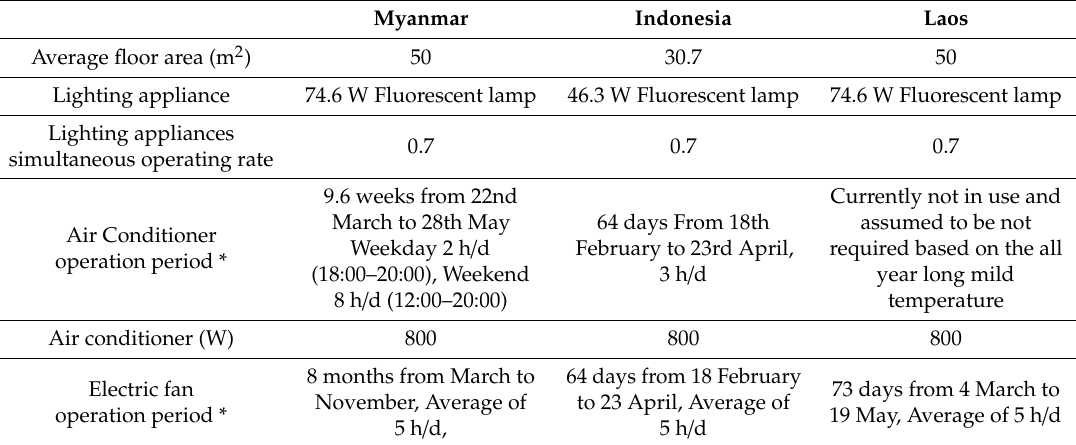
Table 5. Other parameters used to estimate the energy demand in each case study village from key stakeholder interview and secondary